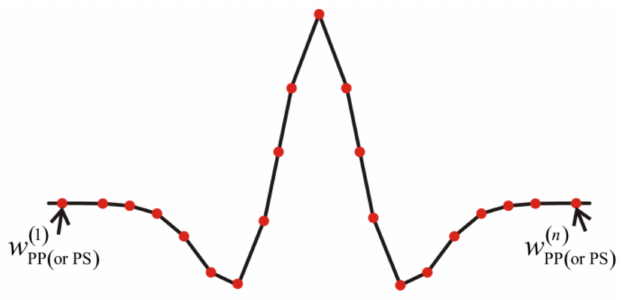
Figure 2. Diagram of the time samples of the PP- or